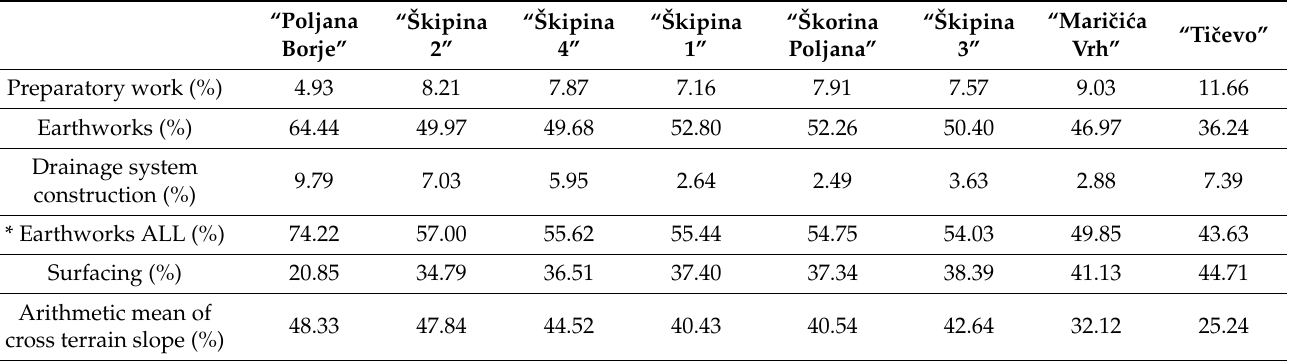
Table 5. Construction cost by phases.